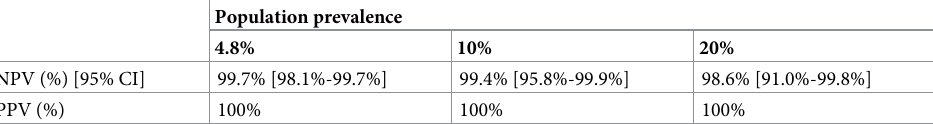
Table 2. Negative predictive values (NPV) and positive predictive values (PPV) based on visual interpretation of VRD results for different population